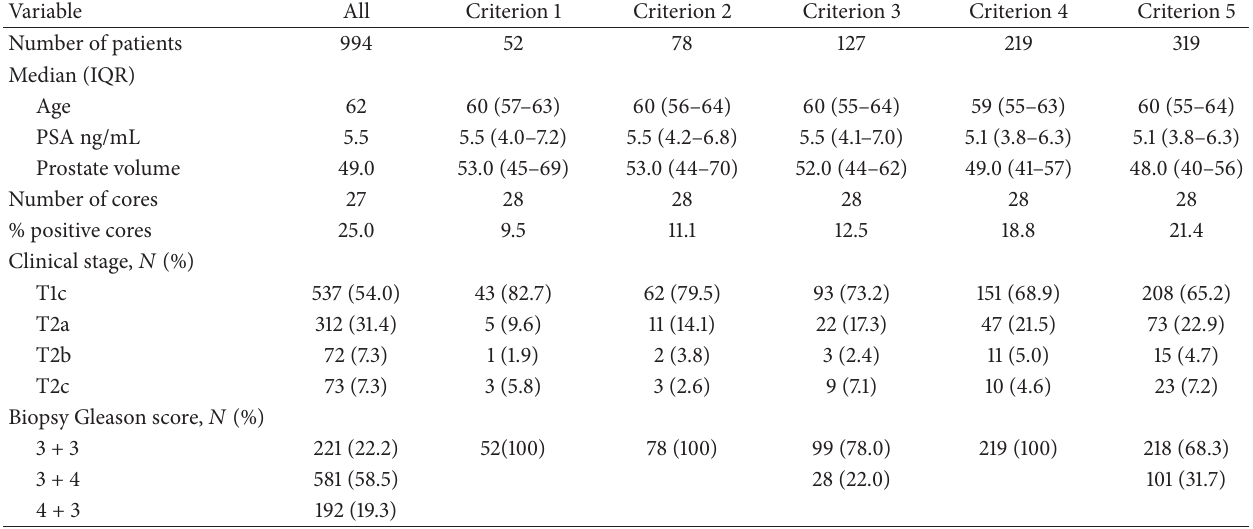
Table 2: Patients characteristics.